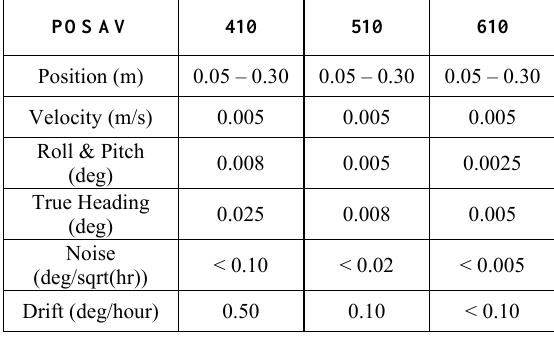
Table 1. Applanix POS/AV Specification (source: Applanix)